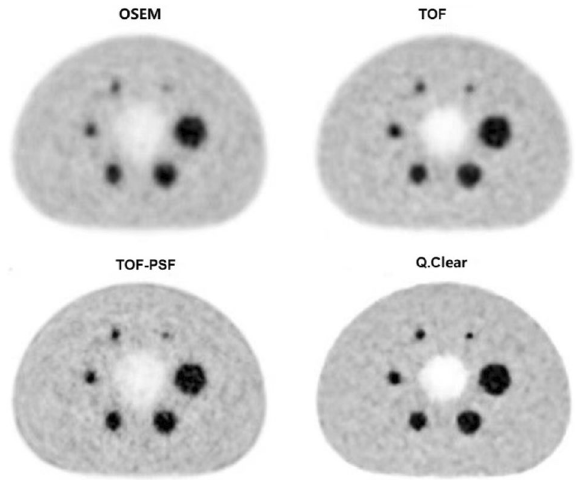
Figure 1. Comparison of PET reconstruction methods for the NEMA phantom with 6 spheres (diameter 10–37 mm) filled with 13.2 kBq/mL Fluoride ions in a 4-to-1 contrast ratio. The mean uptake values (Bq/mL) of the 6 spheres (in order from 10 to 37 mm) for 4 reconstructions were as follow: 4.12, 5.66, 6.57, 7.52, 9.03, 9.78 for OSEM, 5.36, 7.25, 8.32, 8.77, 9.62, 10.24 for TOF, 5.76, 7.86, 8.84, 8.96, 9.67, 10.47 for TOF-PSF, 6.70, 9.09, 9.54, 9.62, 10.99, 11.15 for Q.Clear. All the PET images are displayed on SUV scale